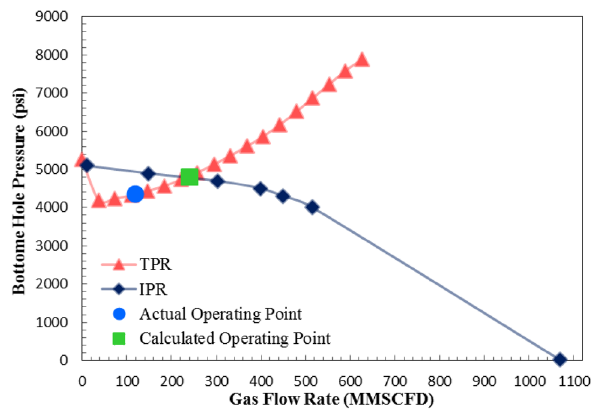
Fig. 10 Comparison of actual and calculated operating